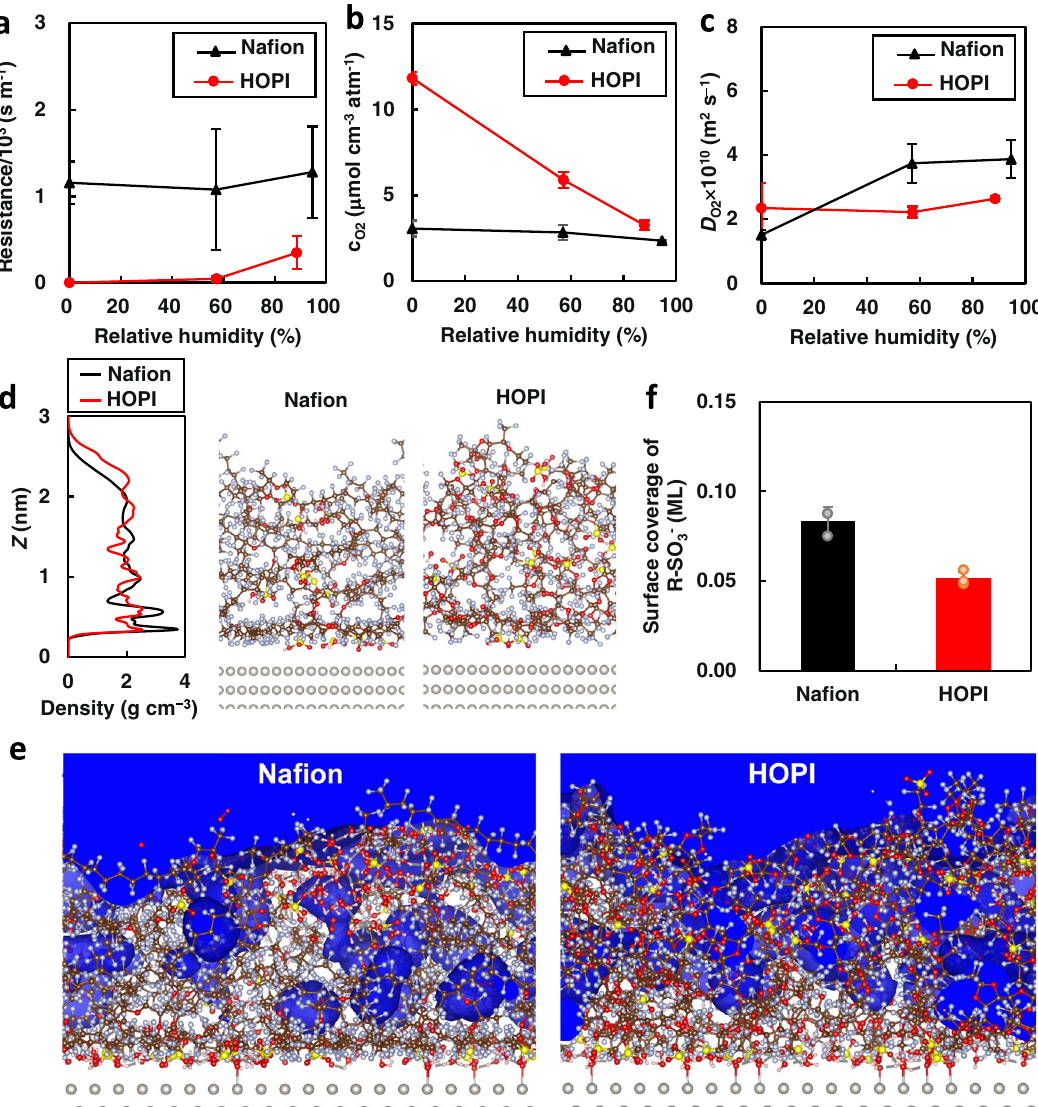
Fig. 5 Bulk and interfacial properties predicted by MD simulations. a – c Simulated oxygen permeation resistance ( a ), oxygen solubility ( b ), and oxygen diffusion coef fi cient ( c ) in Na fi on (black) and HOPI (red). d Density distributions of the ionomer thin fi lms and snapshots of the interfacial structures at RH = 0% ( λ = 0). e 3-dimensional oxygen distributions at RH ≈ 60%. The region with O 2 concentration higher than 7 μ mol cm − 3 atm − 1 is shown in blue. f Surface coverage of sulfonate anions in the ionomers determined from the MD simulations (RH ≈ 60%, λ = 6). The surface coverage was determined from the average number of sulfur atoms present at 0 – 4.5 Å from the Pt surface. In all fi gures, error bars indicate the root means square differences of two to three MD runs started from different initial structures (see details in the “ Methods ” ). White, red, brown, light blue, yellow, and gray spheres in the molecular structures made by the VESTA software 60 indicate H, O, C, F, S, and Pt atoms,